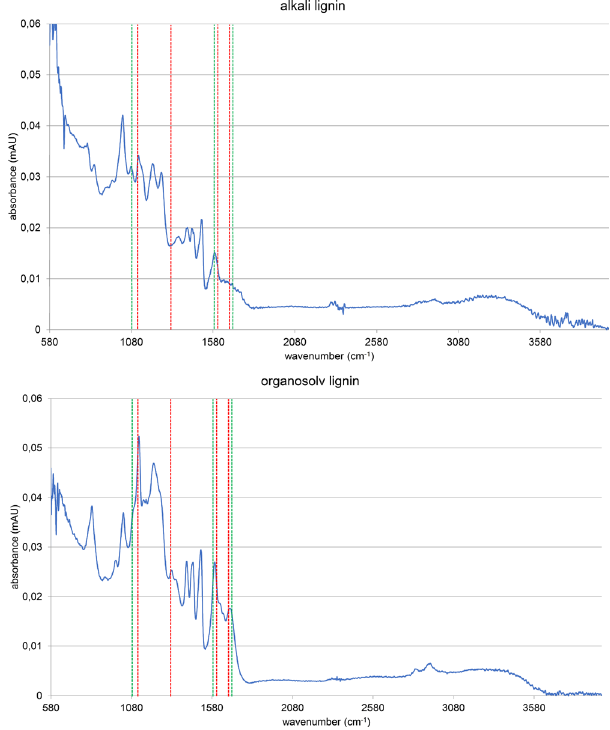
Figure 5. FTIR spectra of precursor alkali lignin (top) and Organosolv lignin (bottom). (Scan range: 500–4000 cm − 1 ). The indicated absorbance bands were adapted from the literature 79 (characteristic softwood absorbance bands are highlighted in green; characteristic hardwood absorbance bands are highlighted in red